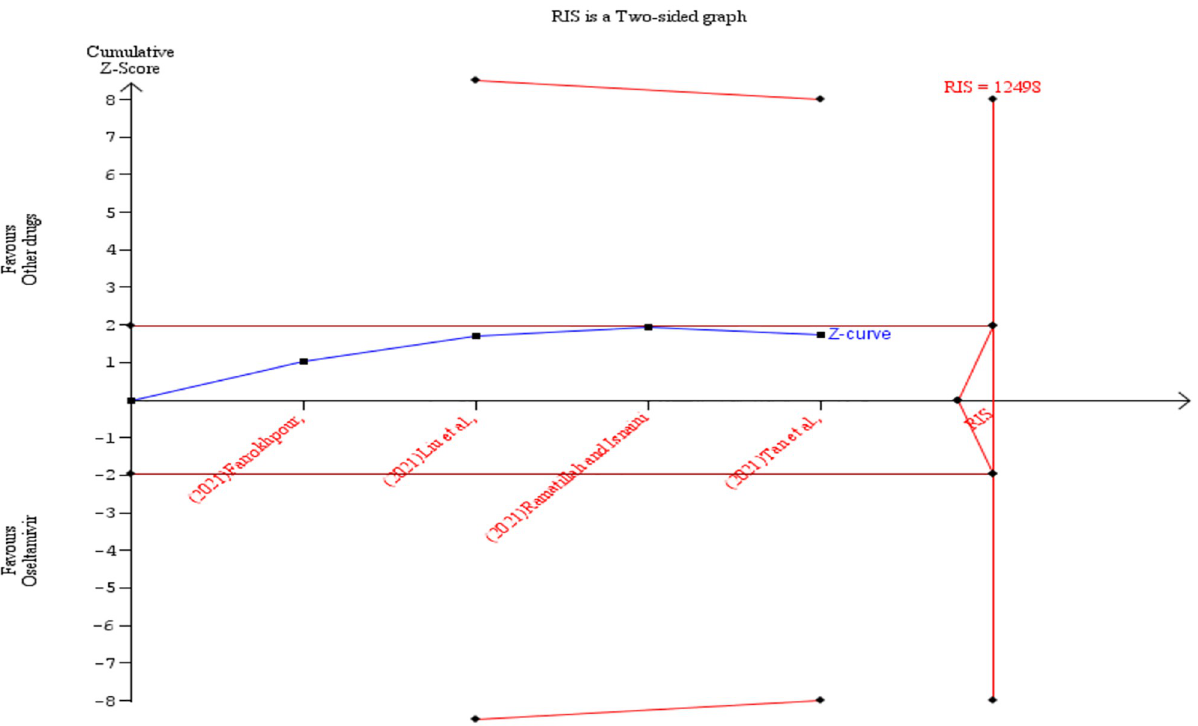
Fig 14. Post-hoc analysis. Shows the trial sequential analysis result comparing the survival of COVID-19 patients treated with oseltamivir versus other drugs after removing one study.